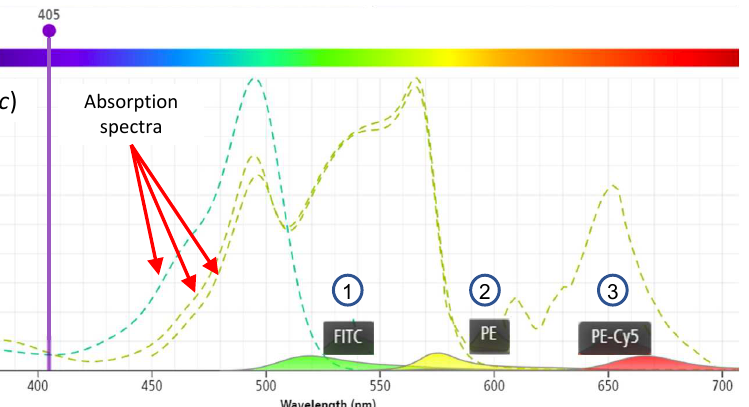
Figure 11. ( a ) Captured image of fluorescence of microbead labeled with FITC fluorophore; ( b ) fluo- rescence of microbeads labeled with PE and PE-Cy5 fluorophores; ( c ) absorption/emission spectra of microbeads under 405nm laser excitation. The beads are in different focal planes, resulting in apparently deformed and fuzzy